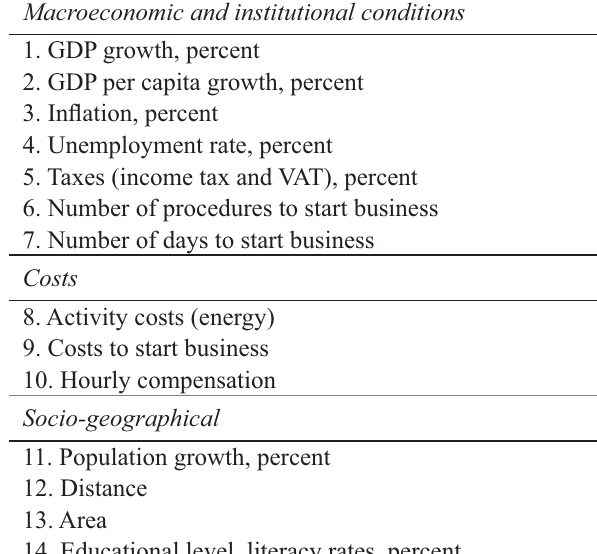
Table 2. Indicators, included into system, being